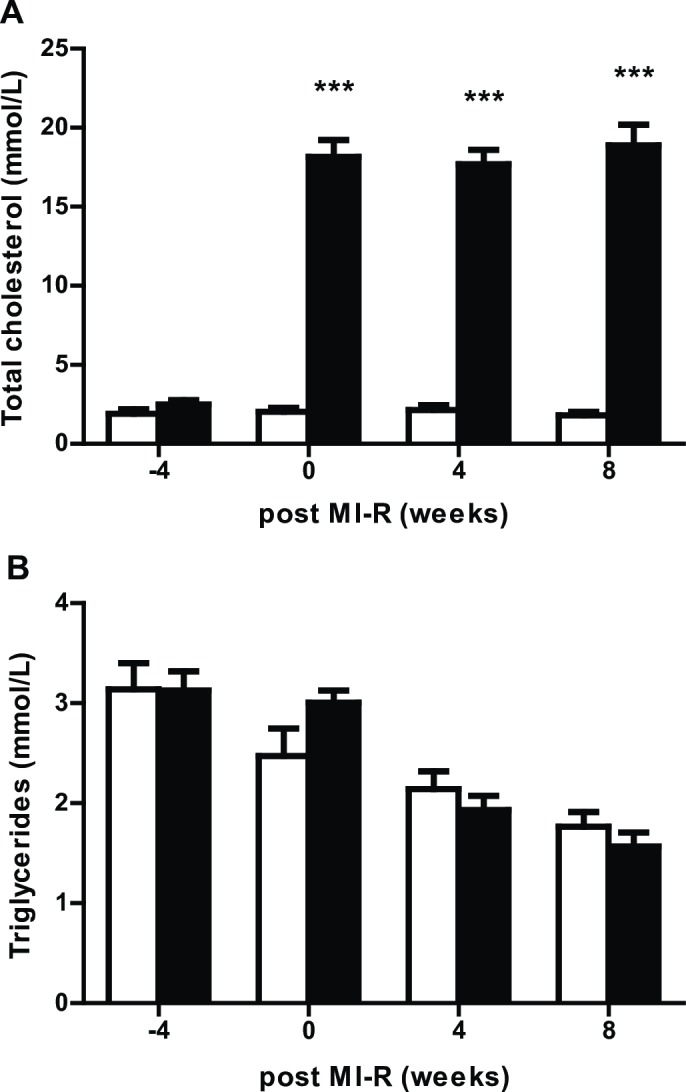
Lipid profiles.Plasma (A) total cholesterol and (B) triglycerides levels in the NC-MI (open bars) and HC-MI (closed bars) group. Data are means ± SEM. ***P<0.001 vs. NC-MI group.